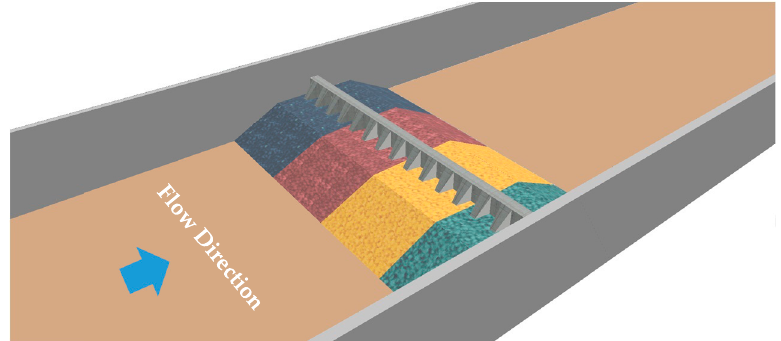
Figure 8. The layout of the spur dike with tooth-shaped structures in the flume [24].